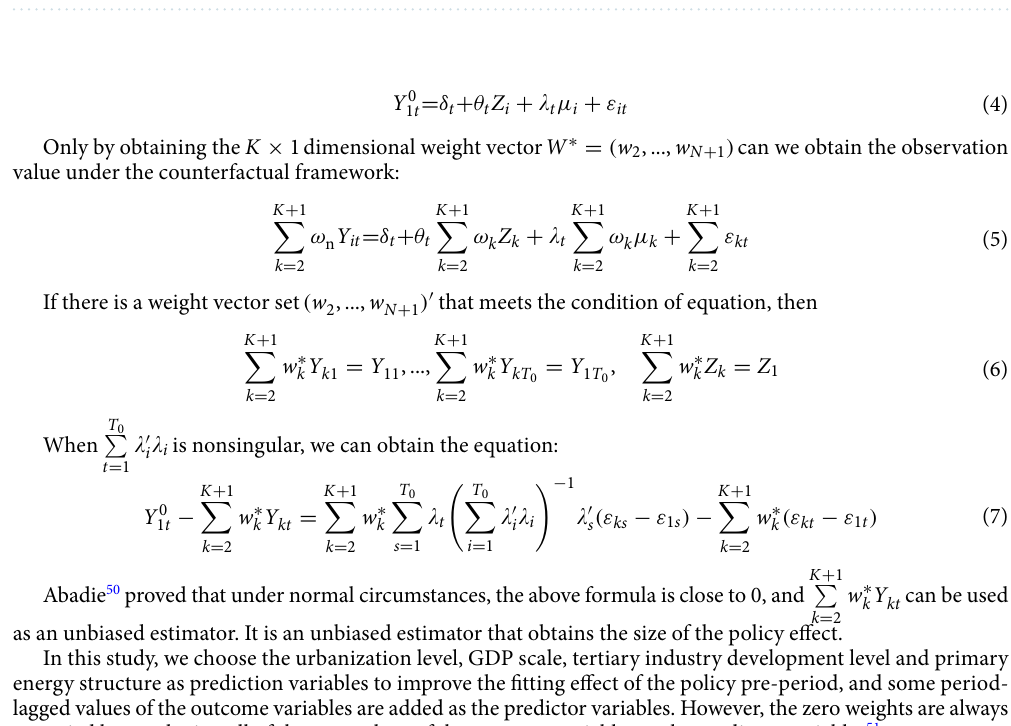
Table 3. Variable descriptive